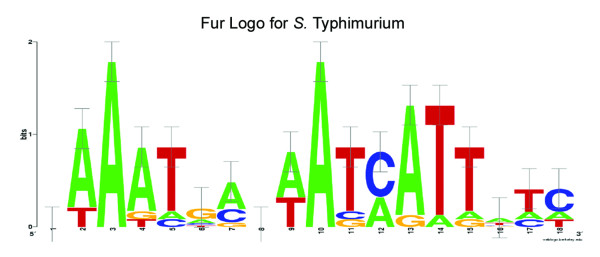
Logo graph of the information matrix from the alignment of Fur-regulated genes in S. Typhimurium. The height of each column of characters represents information, measured in bits, for that specific position and the height of each individual character represents the frequency of each nucleotide.